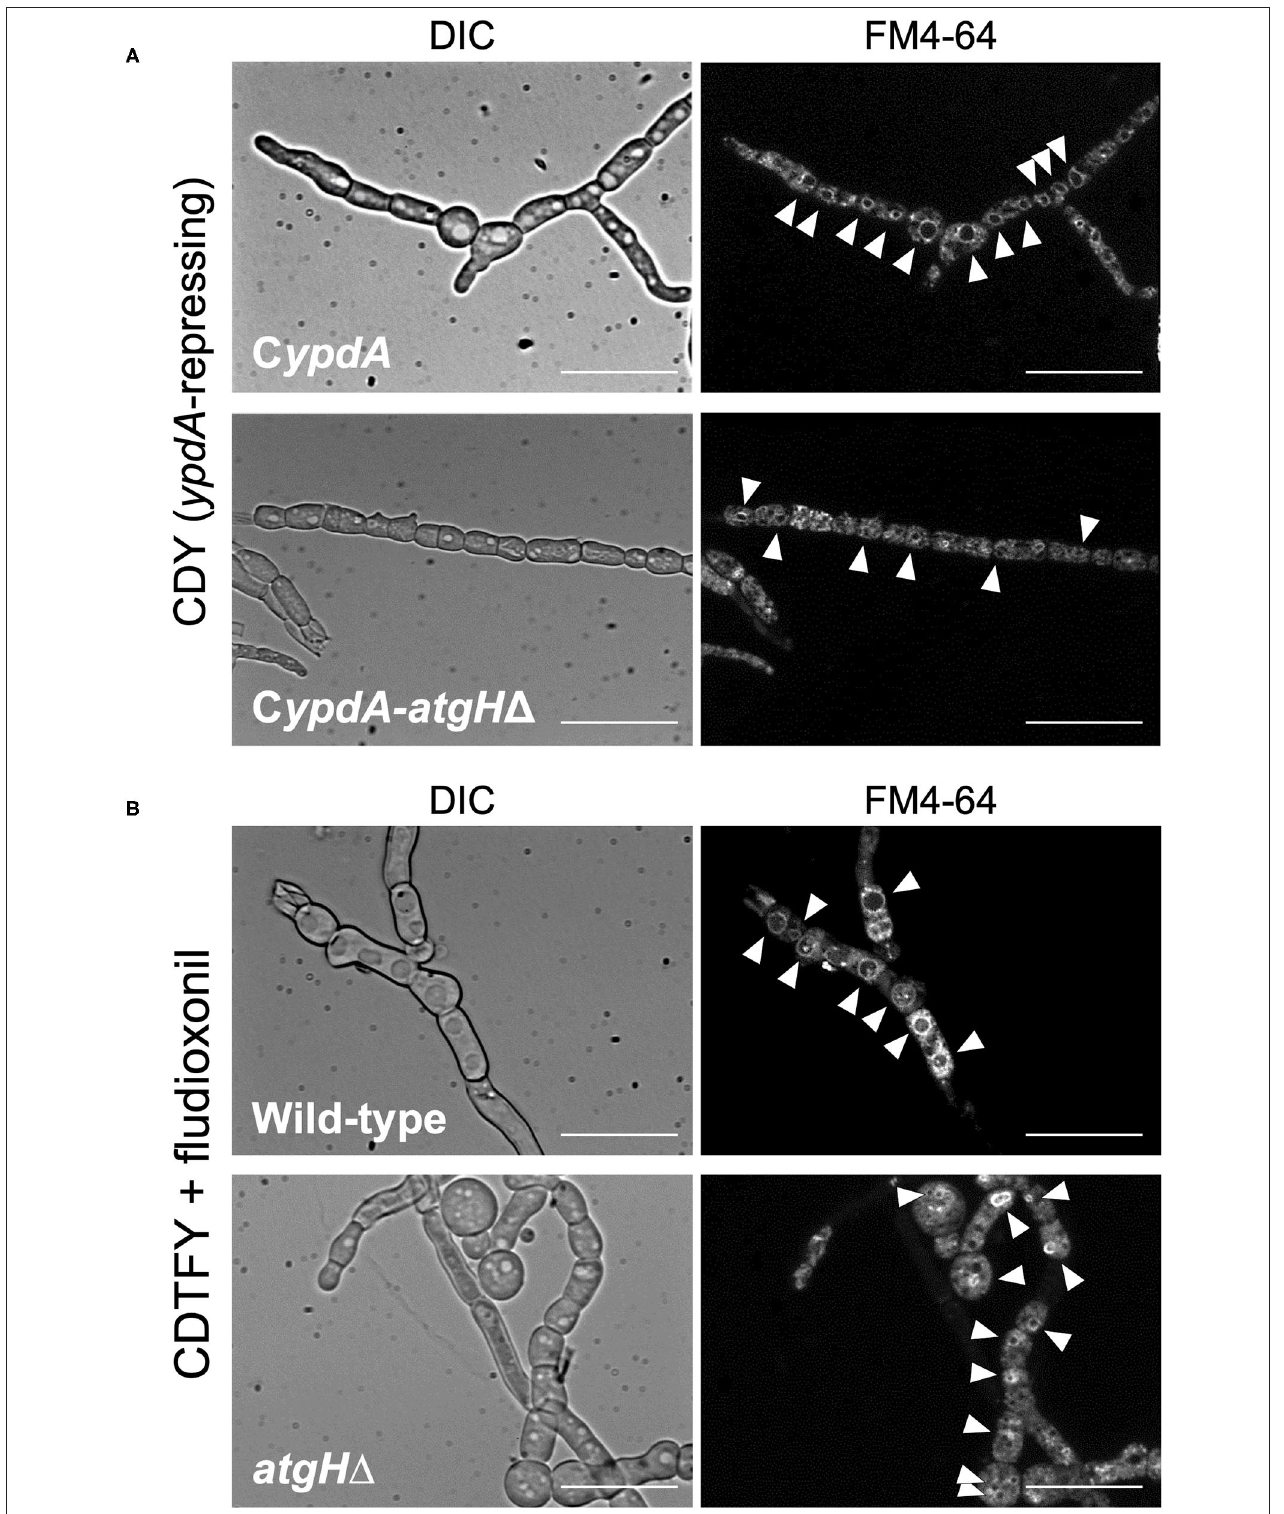
FIGURE 12 | Vacuole morphology of atgH -disrupted strains derived from wild-type and C ypdA strains under the ypdA -repressing condition and fludioxonil treatment. (A) Conidia of the C ypdA and C ypdA - atgH 1 strains were cultured in CDTFY ( ypdA -inducing) medium for 8h at 37 ◦ C. Mycelia were transferred to CDY medium ( ypdA -repressing) and incubated for 4h at 37 ◦ C. Mycelia were stained with FM4-64 and vacuoles were observed by fluorescence microscopy. (B) Conidia of the wild-type and atgH 1 strains were cultured in CDTFY medium for 8h at 37 ◦ C. Mycelia were transferred to CDTFY with 0.1 µ g/ml fludioxonil and incubated for 4h at 37 ◦ C. Mycelia were stained with FM4-64 and vacuoles were observed by fluorescence microscopy. Arrowheads indicate vacuoles. Bars, 35 µ m.